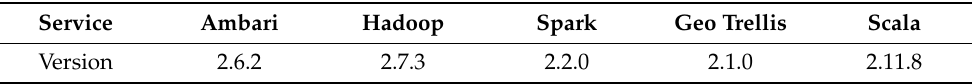
Table 2. Details for the version used for the basic service in the distributed cluster.